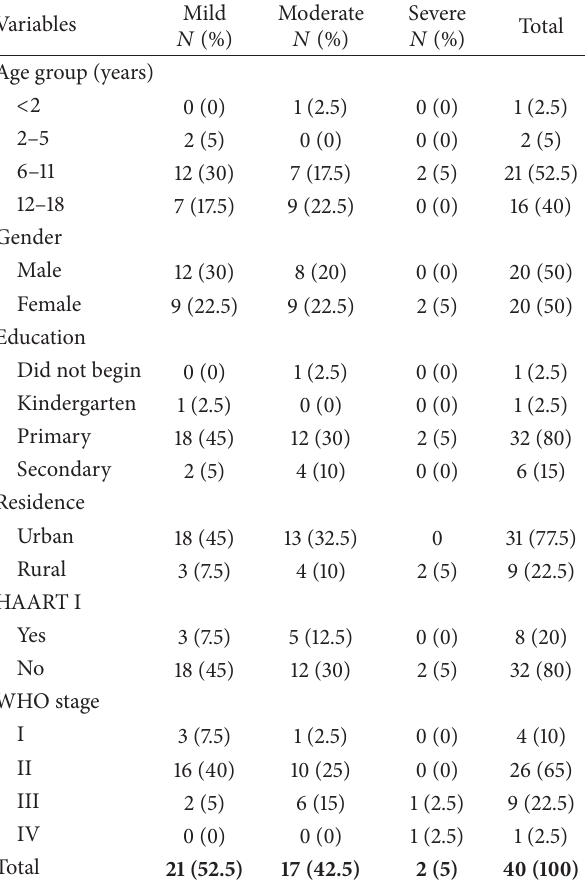
Table 2: Frequency distribution of anemia status among anemic pediatric HIV/AIDS patients attending Zewditu Memorial Hospital from August 5, 2013, to November 25, 2013, Addis Ababa, Ethiopia ( 𝑁 = 40